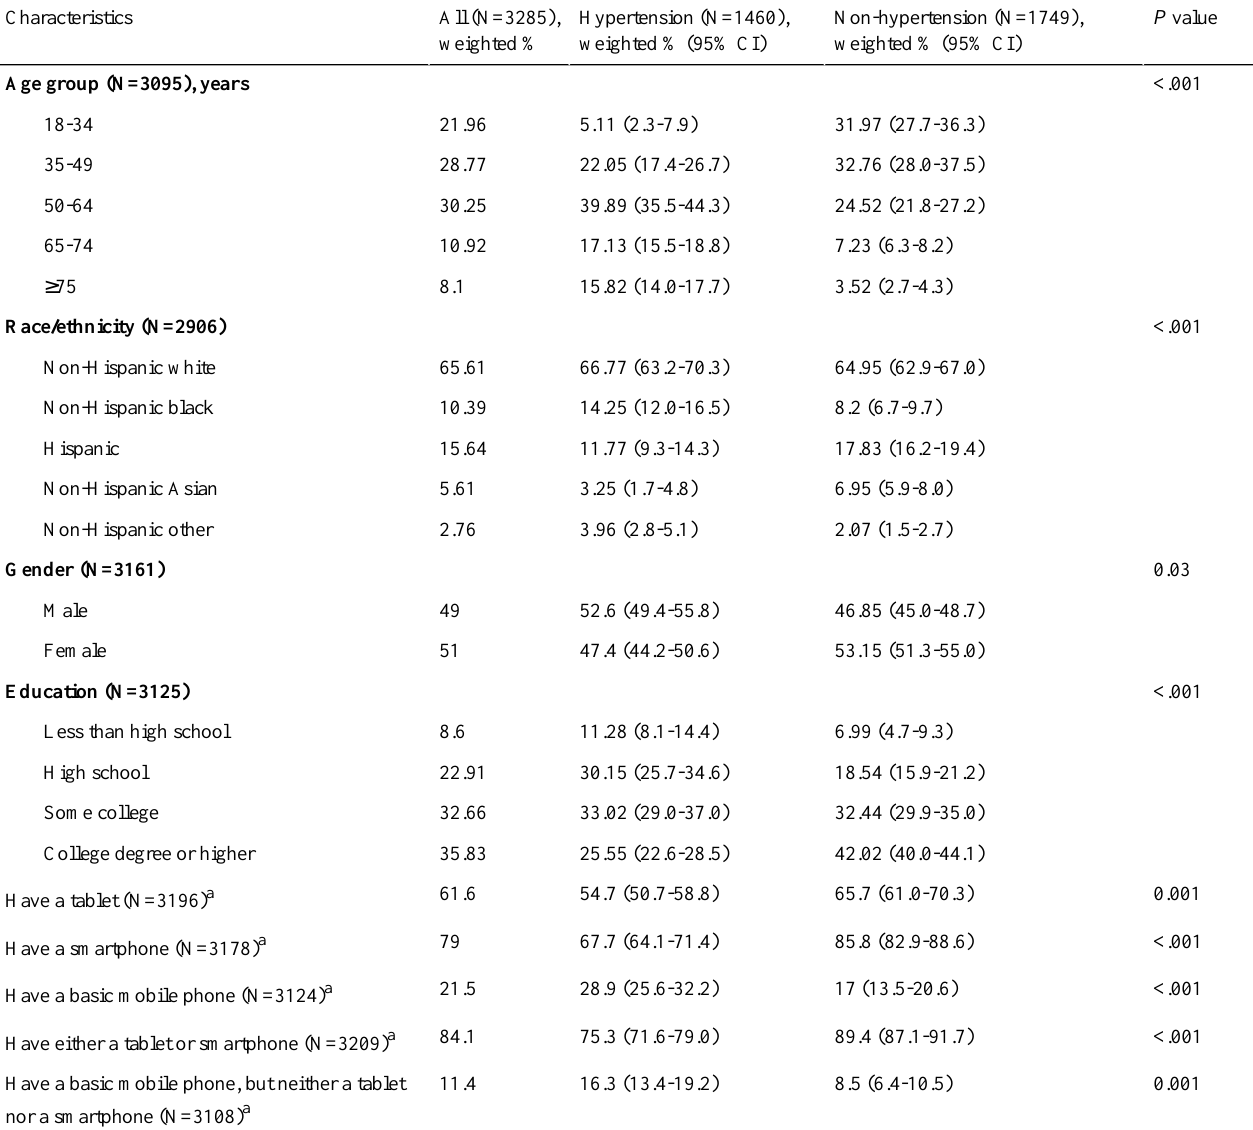
Table 1. Participant characteristics according to the hypertension status.